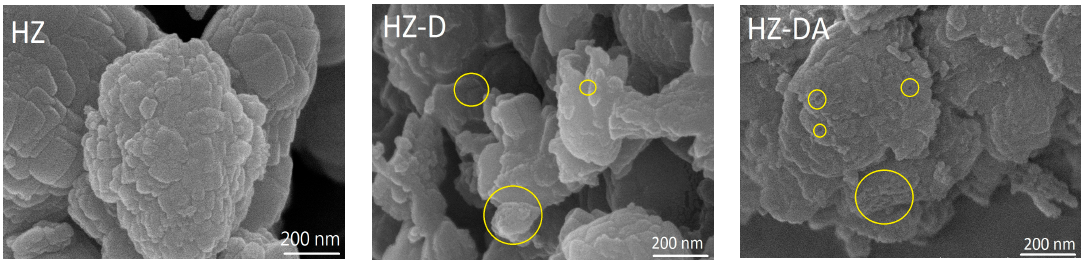
Figure 2. SEM micrographs of HZ, HZ ‐ D, and HZ ‐ DA.